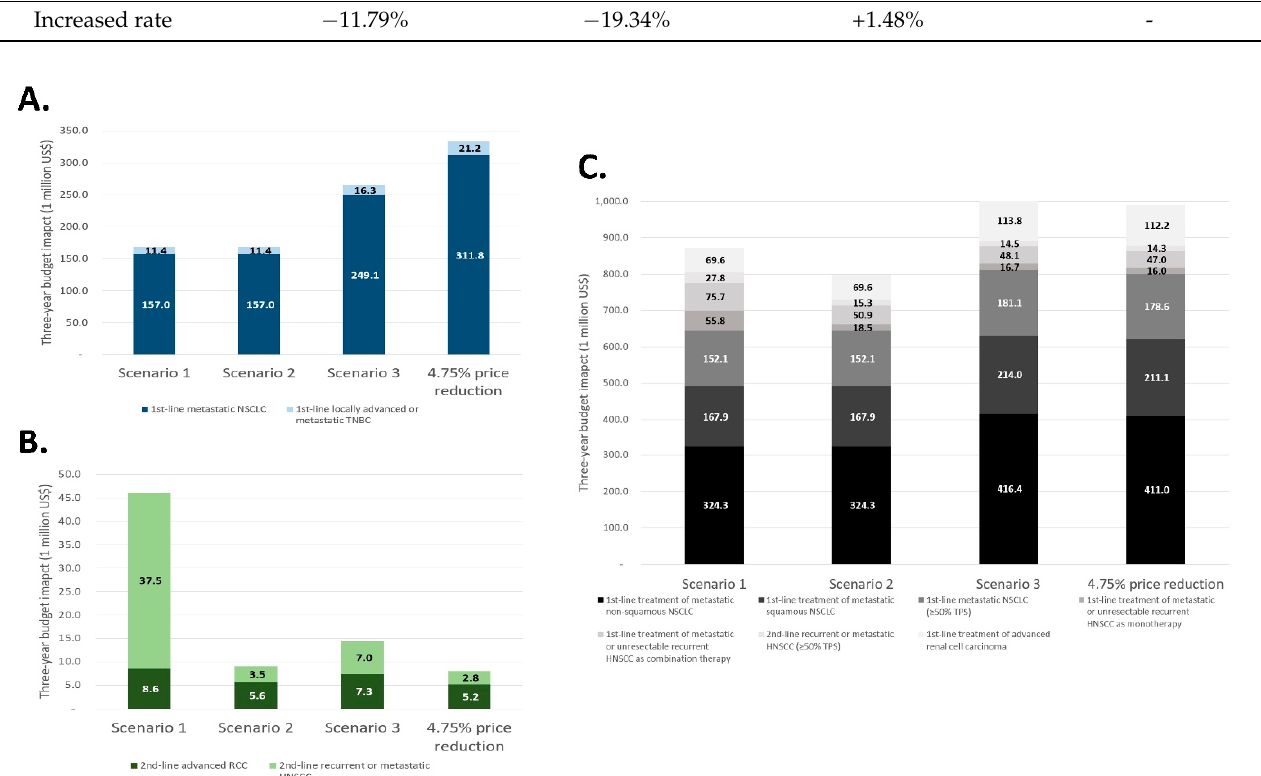
Figure 1. The budget impact for each non ‐ reimbursed indication: ( A ) atezolizumab, ( B ) nivolumab, and ( C ) pembrolizumab. and ( C )